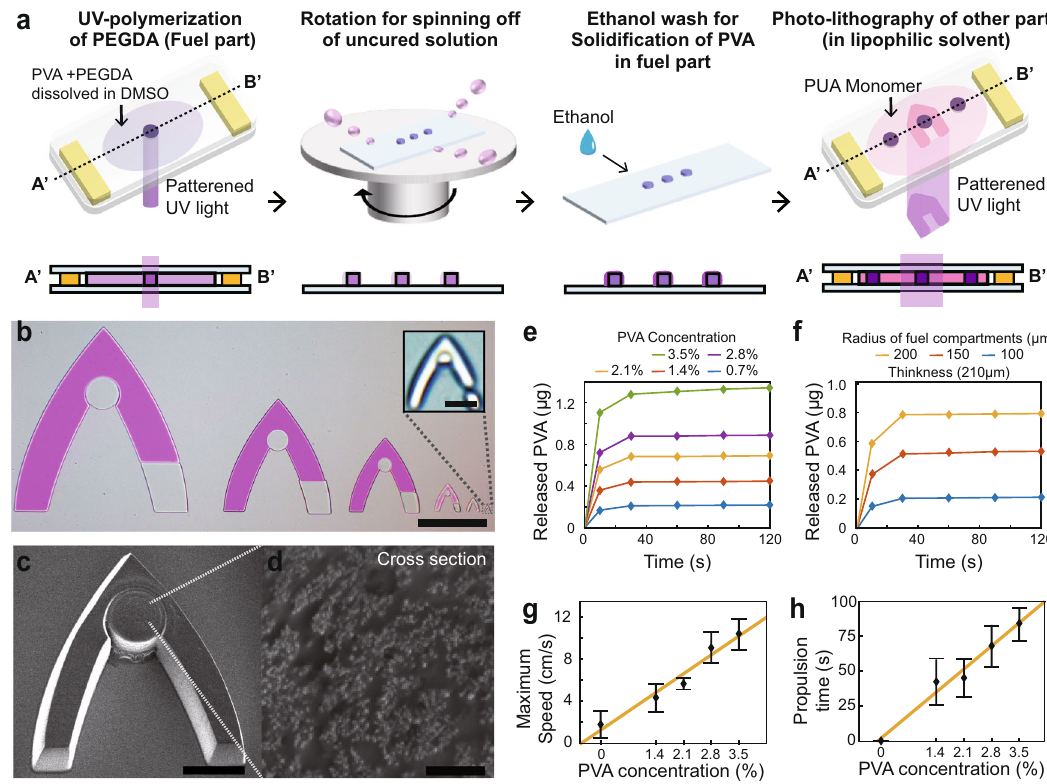
Fig. 2 Photolithography of Marangoni microswimmers enables Marangoni microswimmers with multifunctional parts. a Fabrication method of microswimmers, including PVA-embedded gel; PVA dissolved in photocurable polymer solution does not react during UV polymerization. The uncured solution is spun off and ethanol is introduced to solidify the PVA in the polymeric mesh. An additional fabrication process using a hydrophobic solvent follows. b Variously sized microswimmers; scale bars represent 500 (down left) and 10 µ m (upright). c Scanning electron microscope (SEM) image: single fuel component; scale bar represents 100 µ m. d SEM image: fuel component cross-section; scale bar represents 3 µ m. e Time-course pro fi les of PVA release from fuel compartment (disk of 200 µ m radius, 210 µ m thickness and 6.6 × 10 6 µ m 3 volume) fabricated under various PVA concentration conditions. f Time-course pro fi les of PVA release from disks of various sizes. PVA concentration in pre-polymer solution is 0.7% and all disks have a thickness of 210 µ m. g Maximum microswimmer speed versus PVA concentration added during fabrication, enabling the programmability of the propulsion time of microswimmers ( n = 20). Rocket-like microswimmers with 750 μ m axes were used. The error bars represent the standard deviation (s.d). h Microswimmer propulsion time versus PVA concentration added during the fabrication ( n = 20). Rocket-like microswimmers with 750 μ m axes were used. The error bars represent